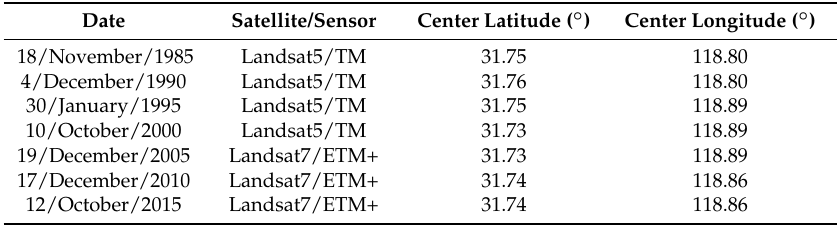
Table 1. Remote sensing data with the resolution of 30 m used in the study area.